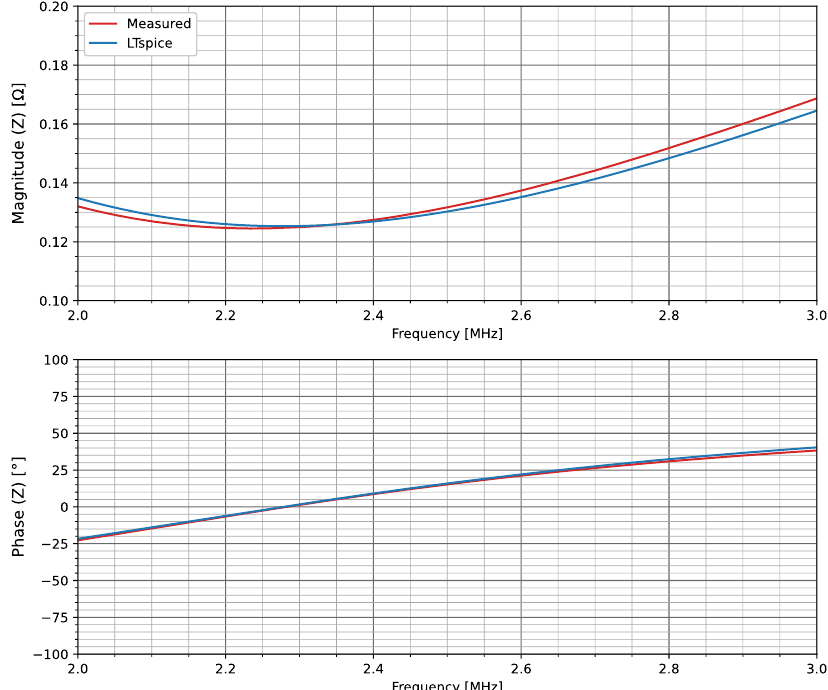
Figure 25. Small PV module measured (shunt-thru) and simulated per-cell impedance curves (frequency range 2MHz to